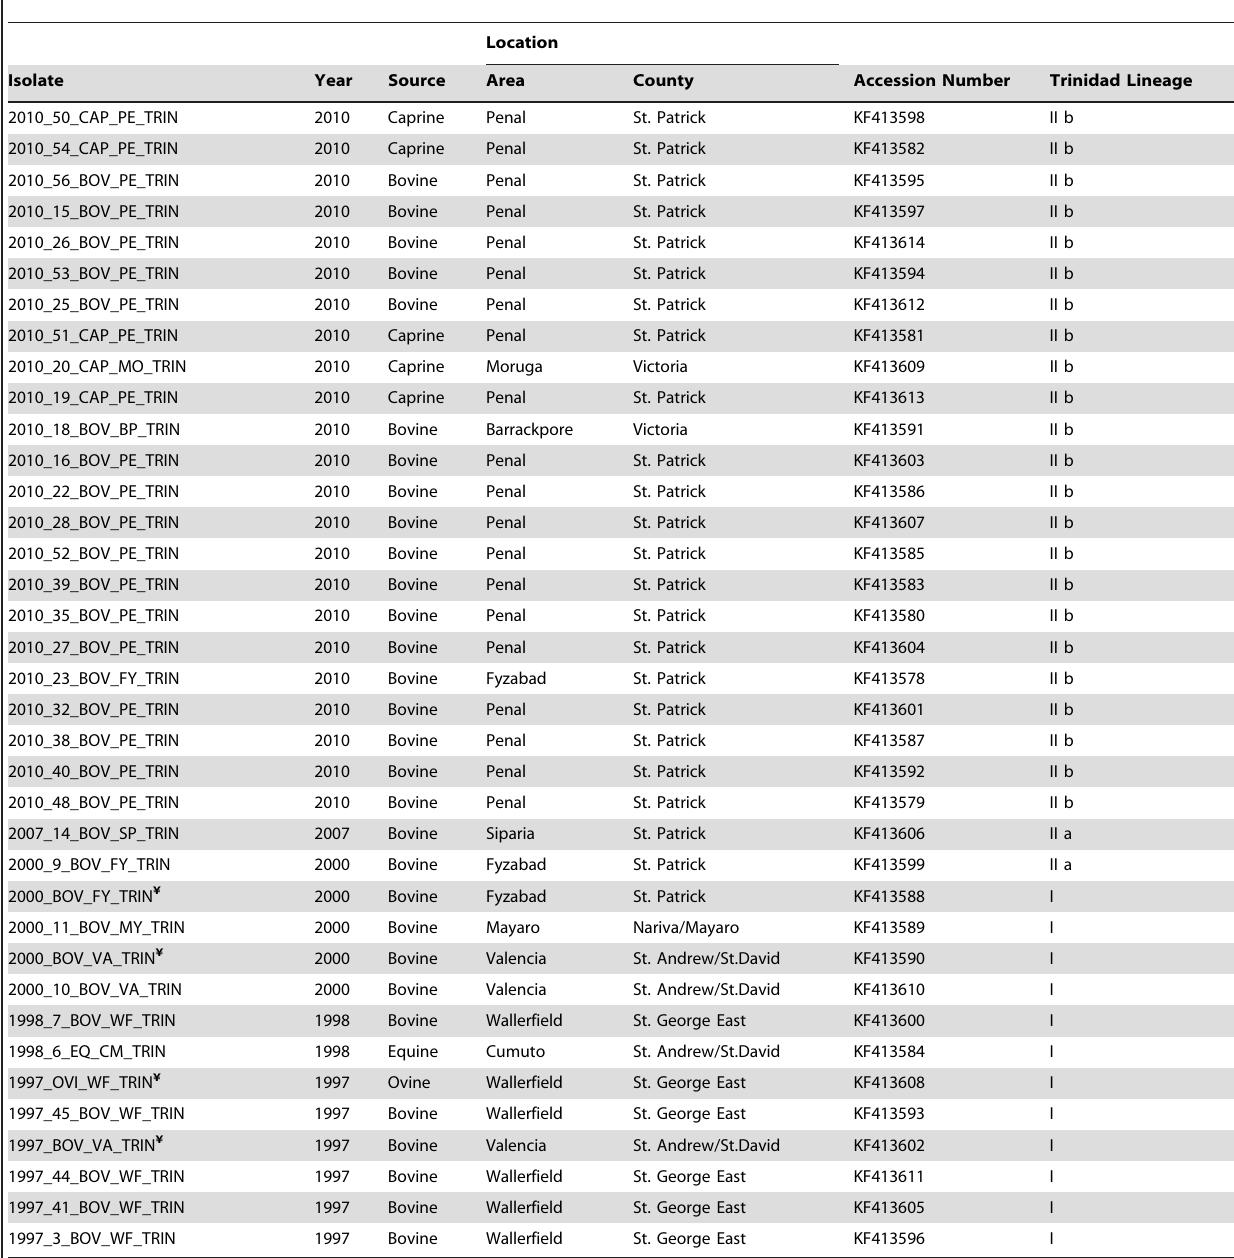
Table 1. Trinidadian sequences used for phylogenetic analysis identified by geographical, temporal and species origin.